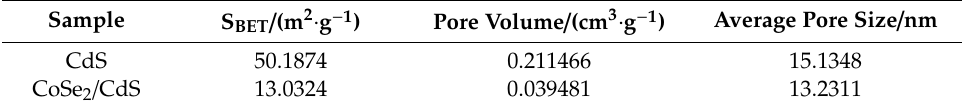
Figure 8. Nitrogen adsorption-desorption isotherms and pertinent pore size distribution curves of pure CdS nanorods and the CoSe 2 /CdS compound. Table 3. Nitrogen isothermal adsorption parameters.